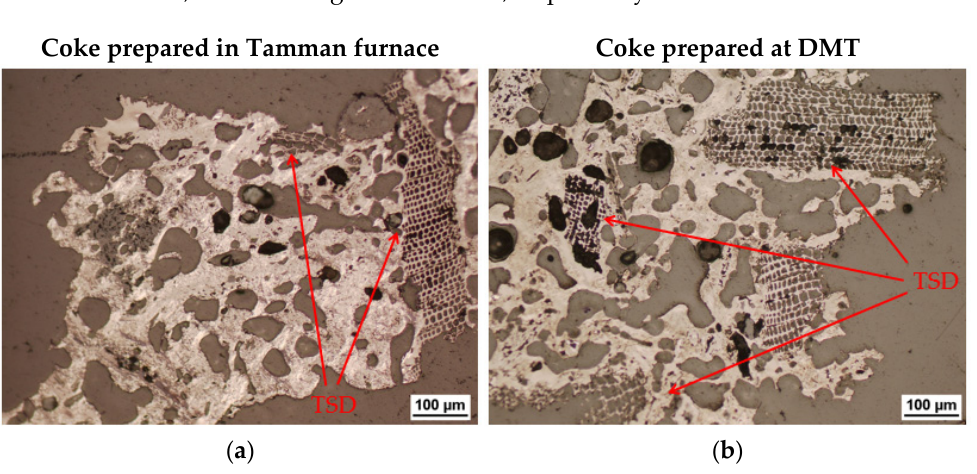
Figure 8. LOM images showing the microstructure for coke and bio-coke samples for ( a ) TSD5 and ( b ) TSD5-DMT. ( b )